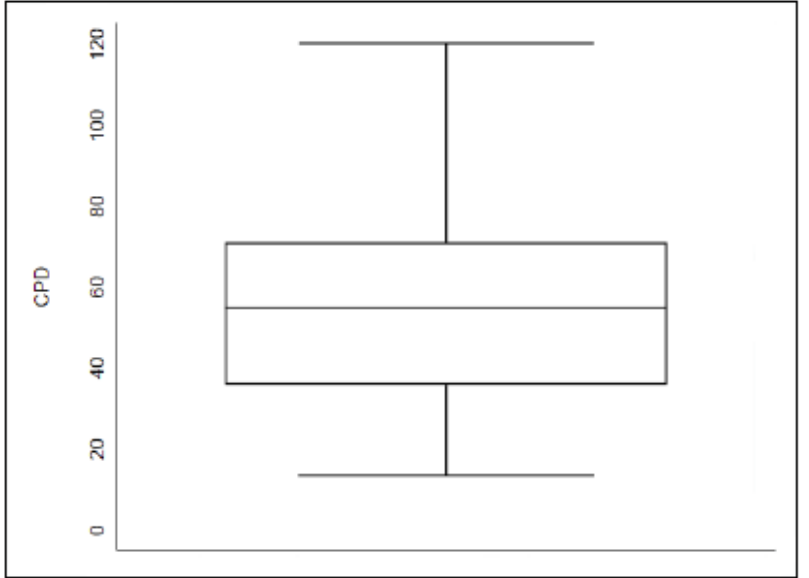
Figure 2. Whisker plot representing the CPD values for all dogs (n = 34). Median CPD value was 54.94 (25th percentile = 36.99; 75th percentile = 70.75). Higher CPD correlates with higher cellular IHC staining intensity of IGF2R.